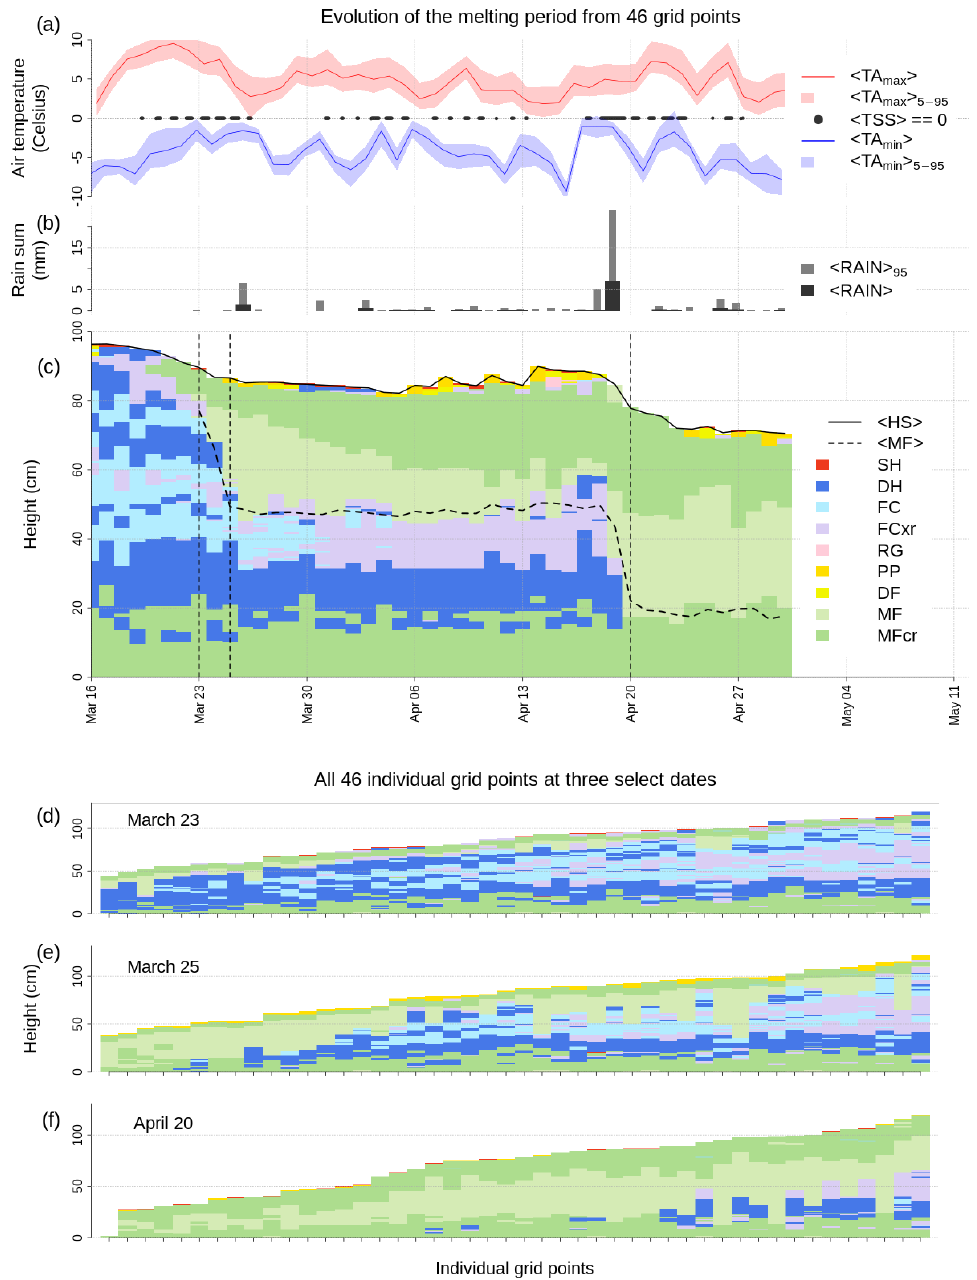
Figure 5. Applying the averaging algorithm to wet snow conditions in spring. (a) Daily maximum and minimum air temperatures (median < ... > and 5–95th percentile envelopes < ... > 5 − 95 ), as well as times when the median snow surface temperature reached zero degrees ( < TSS > == 0). (b) Rain sums (median and 95th percentile). (c) Time series of the average profile with the median snow height < HS > and the median depth of MF grains, i.e., wetting front, ( < MF > ); the dashed lines represent days for which all individual grid points are shown in panels (d–f)